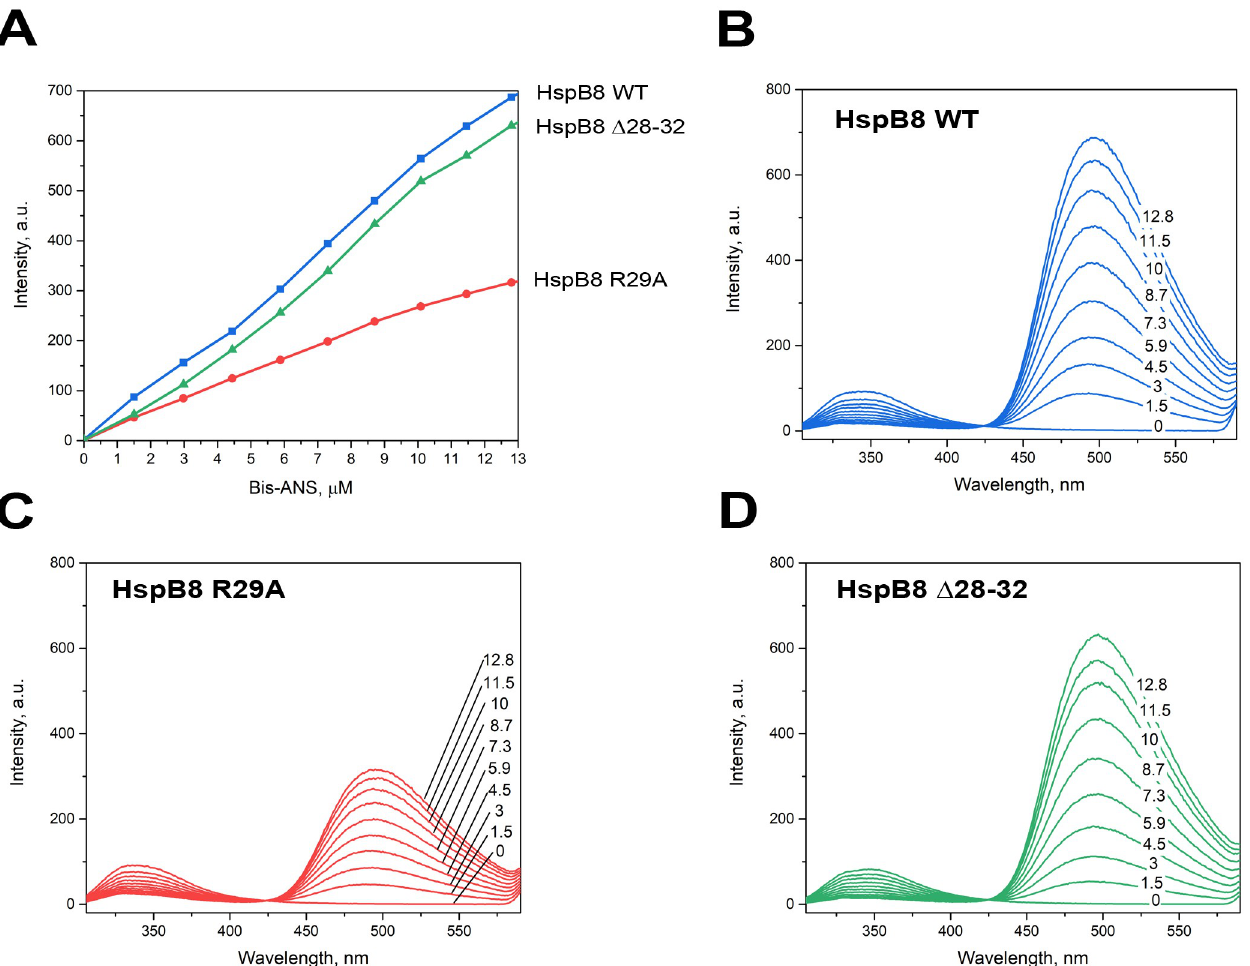
Fig 3. Titration of HspB8 WT and its mutants with hydrophobic probe bis-ANS. A. Increase of bis-ANS fluorescence excited at 385 nm and recorded at 495 nm for HspB8 WT (blue), R29A (red) or Δ 28–32 (green) mutants. B, C, D. Fluorescence spectra excited at 295 nm and recorded after the addition of various bis-ANS concentrations (numbers in μ M on panels) of bis-ANS to 2.3 μ M of either HspB8 WT (panel B), the R29A or the Δ 28–32 mutant (panels C and D), respectively.